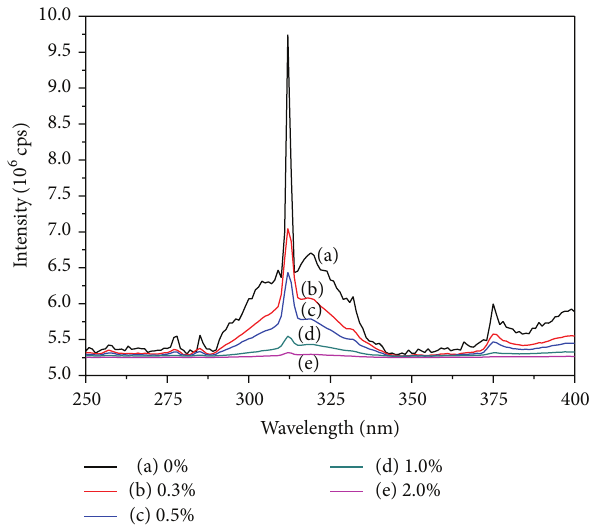
Figure 5: Emission spectra of Li,Pr:Y 2 SiO 5 with different concen- trations of TiO 2 . (a) 0%; (b) 0.3%; (c) 0.5%; (d) 1.0%; (e) 2.0%.